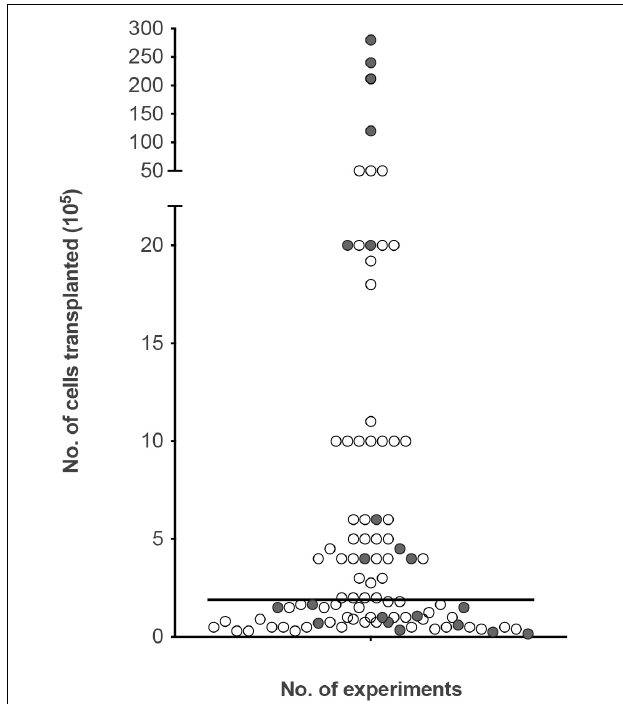
FIGURE 5 | Assessment of cellular dose of olfactory cell transplants in spinal cord injury. A total of 94 experiments were included in the analysis (4 experiments did not provide details of the about the number of cells transplanted). The bar represents the median value of the data analyzed (1.8 × 10 5 or 180,000 cells in total in a transplant, irrespective of cell mixture proportions). The empty circles indicate the positive outcome experiments and the filled circles indicate the negative outcome